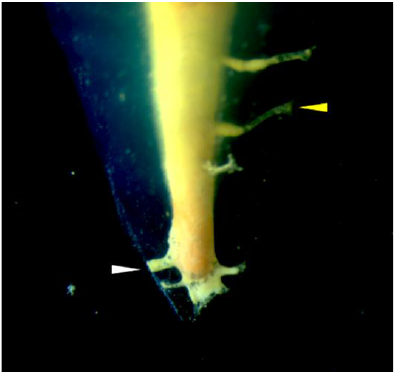
Figure 5. Representative image of a transparent root apex showing complete (white arrow) and partial (yellow arrow) filling of an accessory canal.